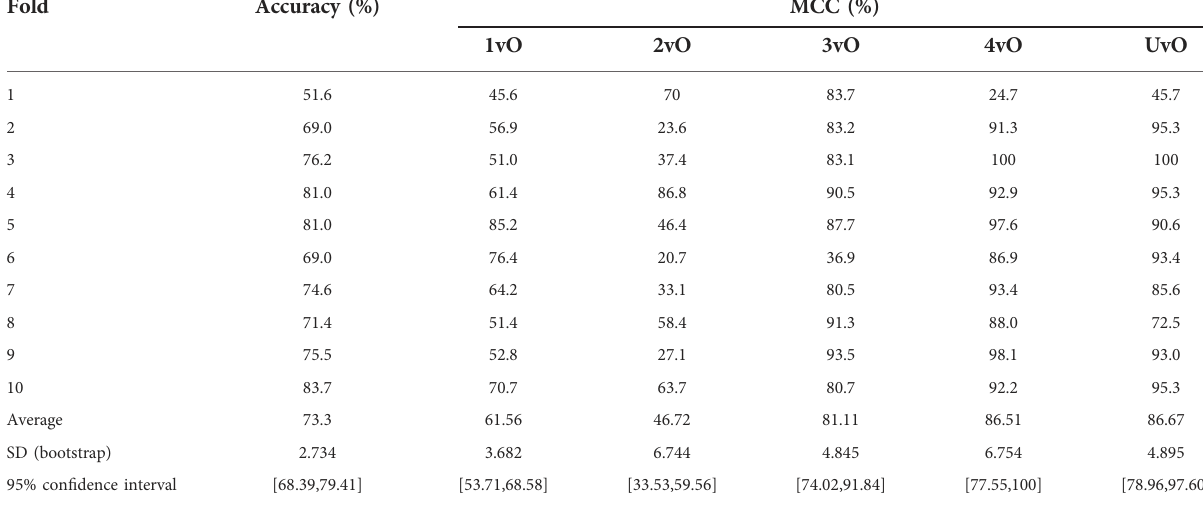
TABLE 2 Accuracy and Matthews correlation coef fi cient (MCC) of the training set of 1,278 pressure ulcer images by 10-fold cross-validation. Fold